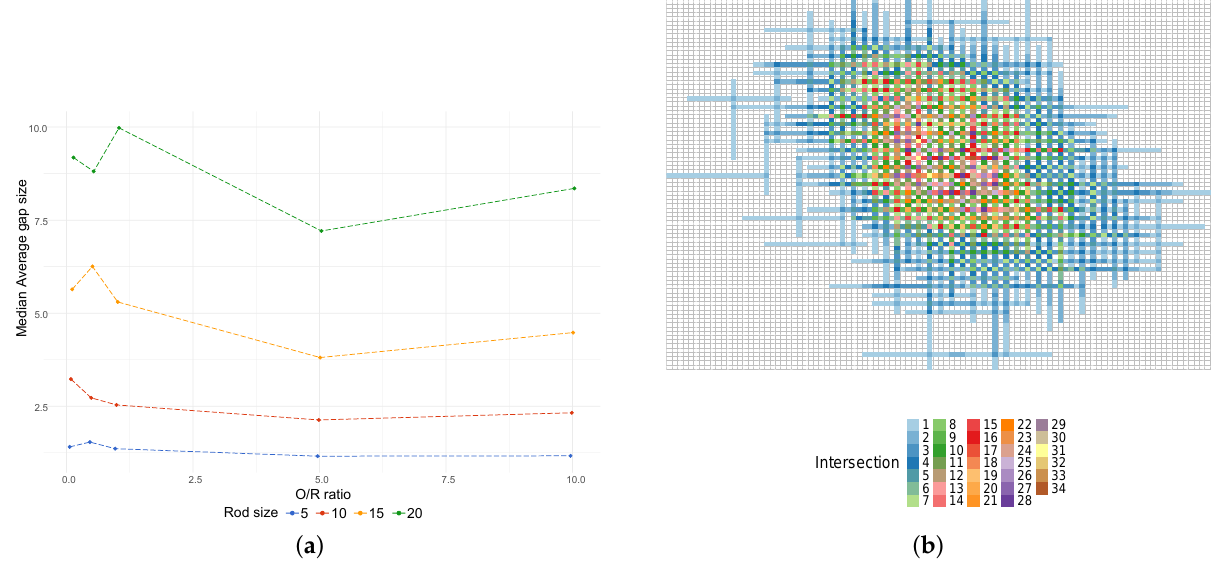
Figure 3. Results of the coarse-grained model: ( a ) dynamics of the assembly averaged gap size per O / R and rod length variation. Each data point is a median of approximately 30 independent runs. The horizontal axes represents the O / R parameter, and the vertical one is the average size of the hole. ( b ) The heat map of the 2D matrix representations of the R object interconnections generated within one run instance of the coarse-grained model for the case when O / R = 0.1 and l = 10. All assemblies contain 1000